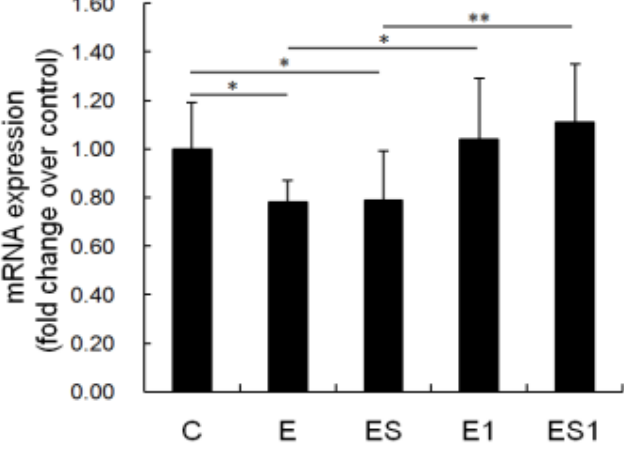
Figure 6. Effects of strenuous exercise and BCAA supplementation on MHC II mRNA level of MФs. Total RNA of macrophages was isolated and reverse transcribed into cDNA. Quantitative PCR was carried out using β -actin as the housekeeping gene. Data are means ± SD. * p < 0.05; ** p < 0.01.